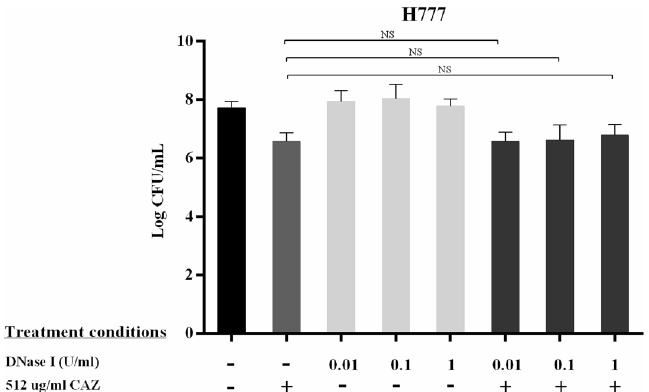
Figure 8. DNase I combined with CAZ failed to kill B. pseudomallei H777 cells in pre-formed biofilm. The 24 h pre-formed B. pseudomallei H777 biofilm grown on pegs in 96-well plates was treated with 0.01, 0.1 or 1 U/mL DNase I and/or 512 µg/mL CAZ for another 24 h. The 2-day viable biofilm cells were liberated by sonication for bacterial enumeration. The experiment was performed in duplicate in each of three independent experiments. NS indicates no significant